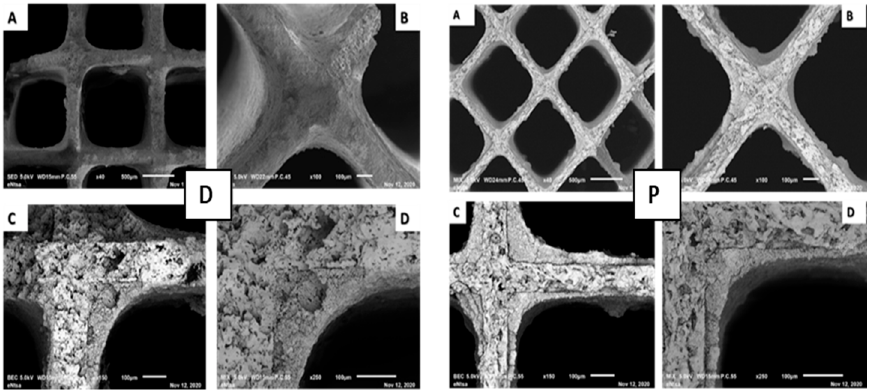
Figure 4. Scanning electron micrographs (SEM) of diesel (D) and petrol (P) spent catalytic converters, at different magnifications where (( A ): 500 µm (×40), ( B ): 100 µm (×100), ( C ): 100 µm (×150) and ( D ): 100 µm (×250)).